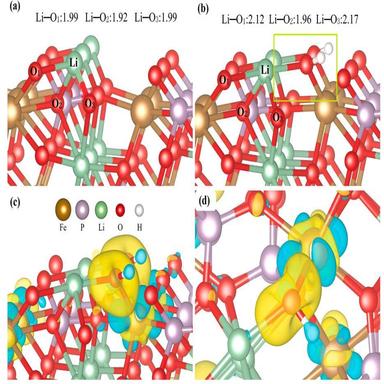
The optimized geometries of (a) LFP and (b) •OH adsorption on the LFP. The (c) right-view and (d) top-view charge density difference (Δρ) plot of the stable •OH adsorption configuration. Yellow and Blue colors represent electron accumulation and depletion, respectively.